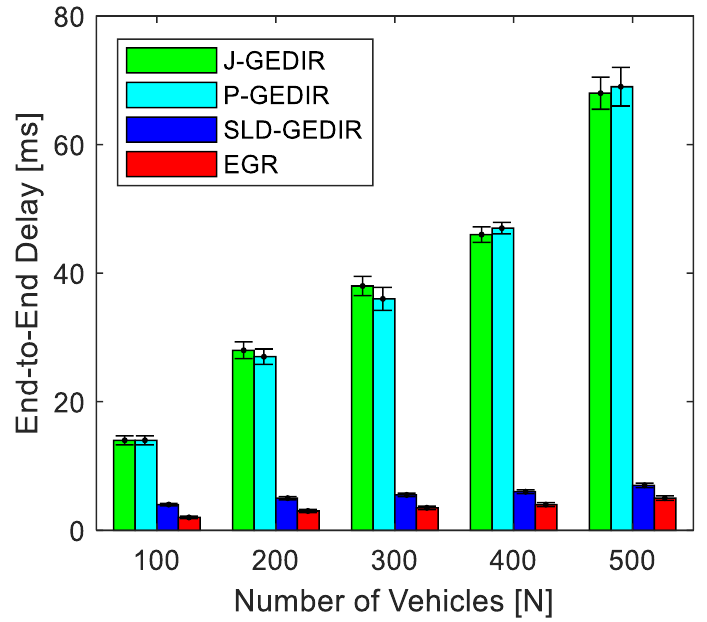
Figure 14. Effect of vehicle density on end-to-end delay.